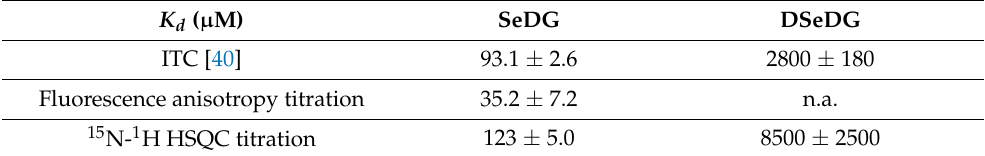
Table 1. Dissociation constants of selenoglycosides to h Gal ‐ 3 measured with different methods. K d ( μ M) SeDG DSeDG ITC [40] 93.1 ± 2.6 2800 ± 180 Fluorescence anisotropy titration 35.2 ± 7.2 n.a. 15 N ‐ 1 H HSQC titration 123 ± 5.0 8500 ± 2500